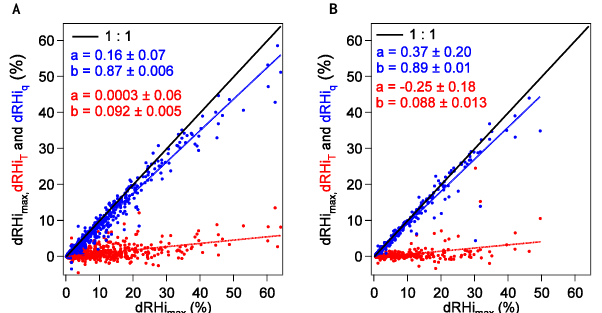
Fig. 9. Contributions from H 2 O ( d RHi q ) and T ( d RHi T ) to the d RHi max inside the ISSRs in the clear-sky (A) and in-cloud (B) con- ditions. The number of ISSRs in clear-sky (A) and cloudy (B) con- ditions is 783 and 273, respectively.